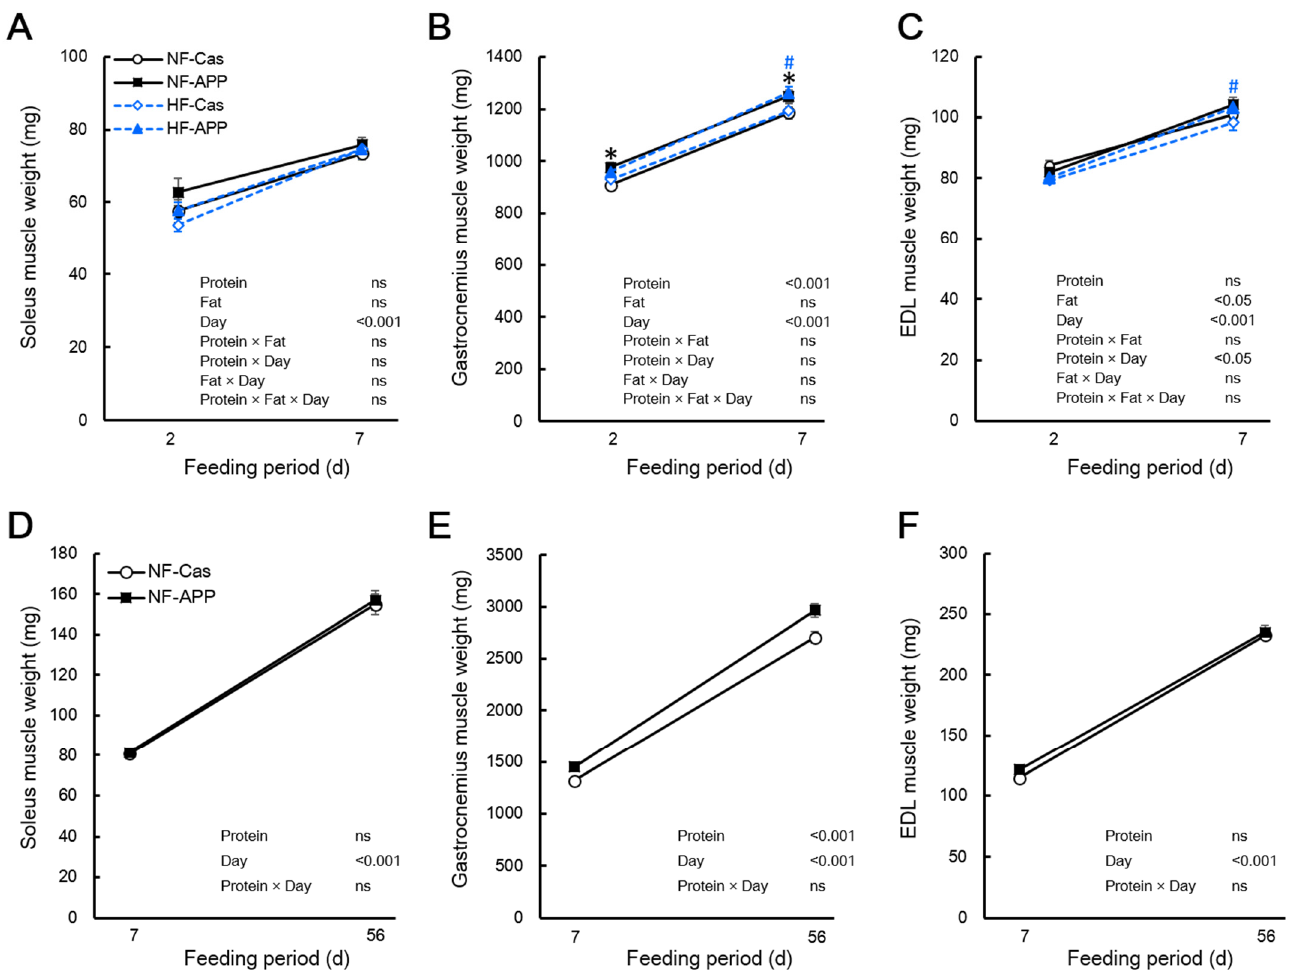
Figure 2. Effects of APP on the skeletal muscle mass. The soleus ( A ), gastrocnemius ( B ), and extensor digitorum longus (EDL) ( C ) of the normal-fat-casein (NF-Cas) group, the normal-fat-APP (NF-APP) group, the high-fat-Cas (HF-Cas) group, and the high-fat-APP (HF-APP) group after 2 days of feeding ( n = 8/group) and 7 days feeding ( n = 9/group) in experiment 1, and the soleus ( D ), gastrocnemius ( E ), and extensor digitorum longus (EDL) ( F ) of the NF-Cas group and NF-APP group after 7 days of feeding ( n = 10/group) and 56 days feeding ( n = 10/group) in experiment 2 are shown. Data are expressed as the mean ± standard error (SEM). Statistical analyses were performed using three-way ANOVA with Bonferroni post hoc significance testing in experiment 1, and two-way ANOVA with Bonferroni post hoc significance testing in experiment 2. Asterisks indicate significant differences compared to the NF-Cas group (* p < 0.05), and a number signs indicate significant differences compared to HF-Cas group ( # p < 0.05). Protein, effect of protein source; Fat, effect of fat content; Days, effect of feeding period; Protein × Fat, interaction between protein source and fat content; Protein × Days, interaction between protein source and feeding period; Fat × Day, interaction between fat content and feeding period; Protein × Fat × Day, interaction between protein source, fat content and feeding period; ns, not significant.